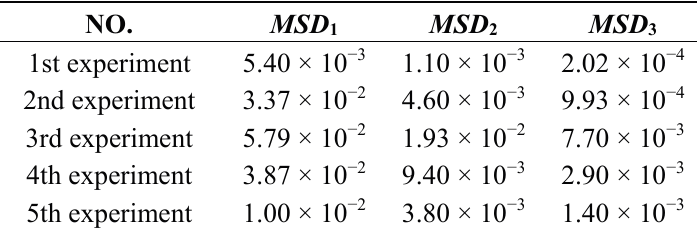
Figure 12. The primary outputs and the compensated outputs from diverse IFOGs. ( a ) The primary outputs and the compensated outputs from NO.1 IFOG; ( b ) The primary outputs and the compensated outputs from NO.2 IFOG. Table 3. MSD from NO.1 IFOG.